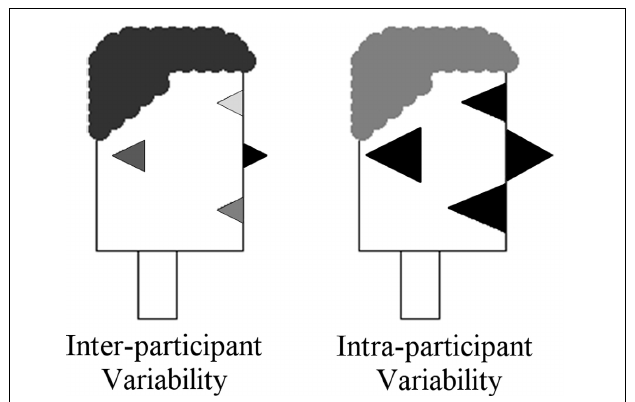
FIGURE 12 | Inter-participant variability (Left) coded by feature shading and intra-participant variability (Right) coded by hair